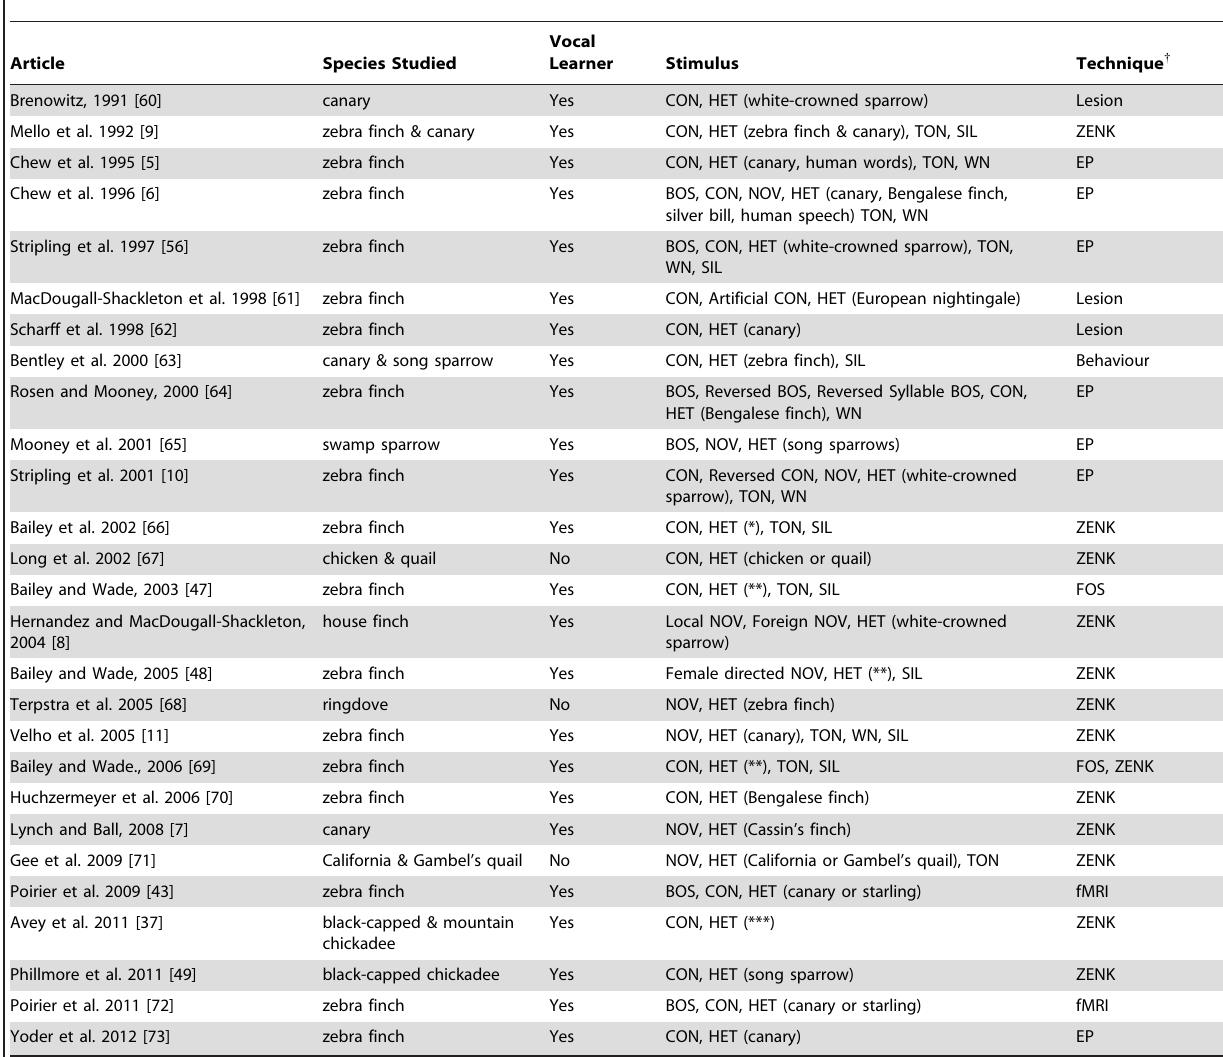
Table 4. Behavioural Neuroscience Research Articles That Use Vocal Stimuli from Heterospecific